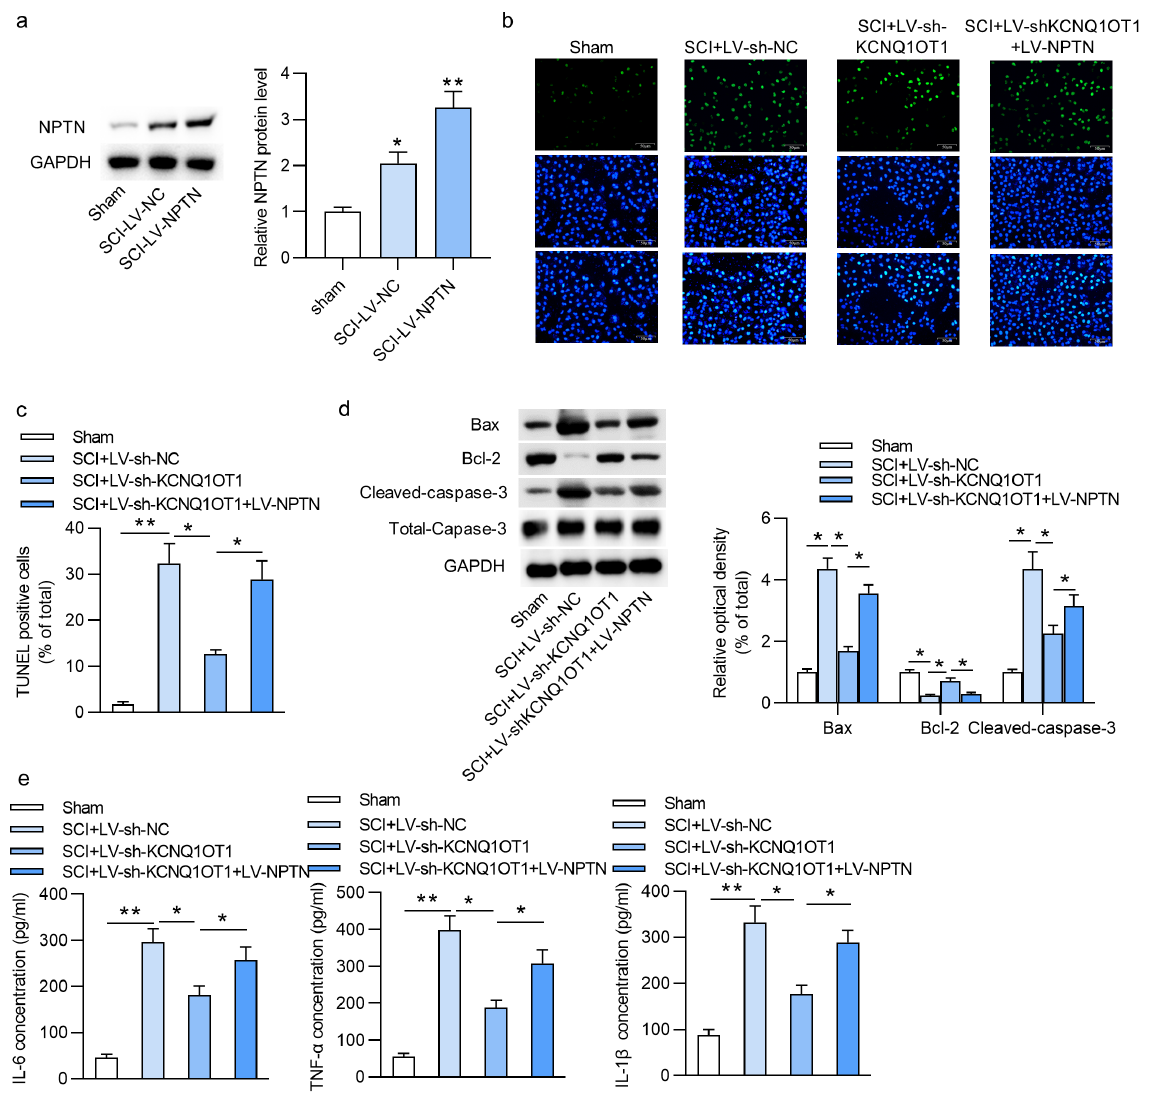
Figure 5. KCNQ1OT1 promoted the apoptosis of microglia and inflammatory response by regulating NPTN in SCI. (a) RT-qPCR and western blot analyses disclosed the mRNA and protein levels of NPTN in SCI mice after injection of LV-NPTN. (b-c) The number of TUNEL positive cells in different groups was assessed by TUNEL staining. (d) The protein levels of Bax, Bcl-2 and Cleaved-caspase-3 in SCI mice were detected by western blot analysis. (e) ELISA measured the concentrations of IL-6, TNF-α and IL-1β in different groups. N=8 in each group. * p < 0.05. ** p <